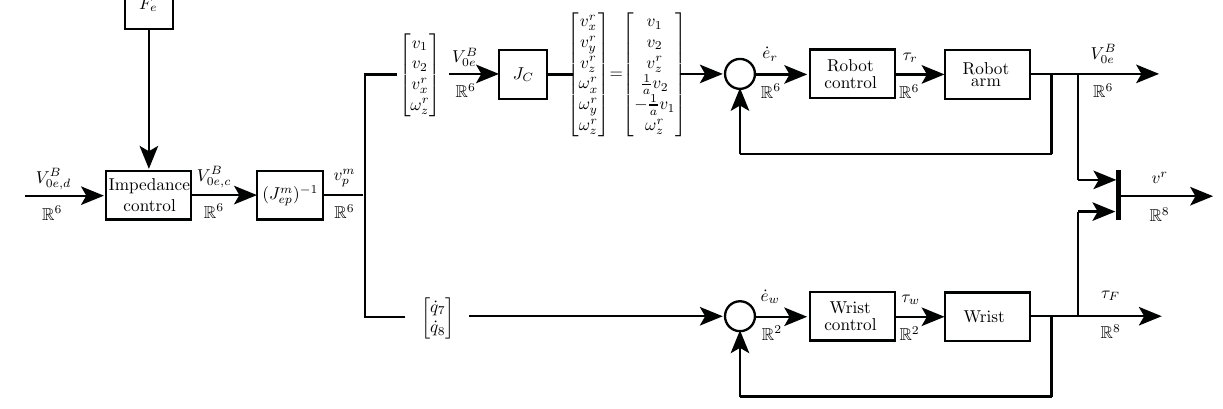
Figure 5: An impedance control scheme which first imposes the desired impedance control on the end-effector variables and then, through the constrained Jacobian matrix ( J m point constraints are satisfied. Note that both the robot and wrist can be controlled using the standard controllers available with most industrial manipulators.